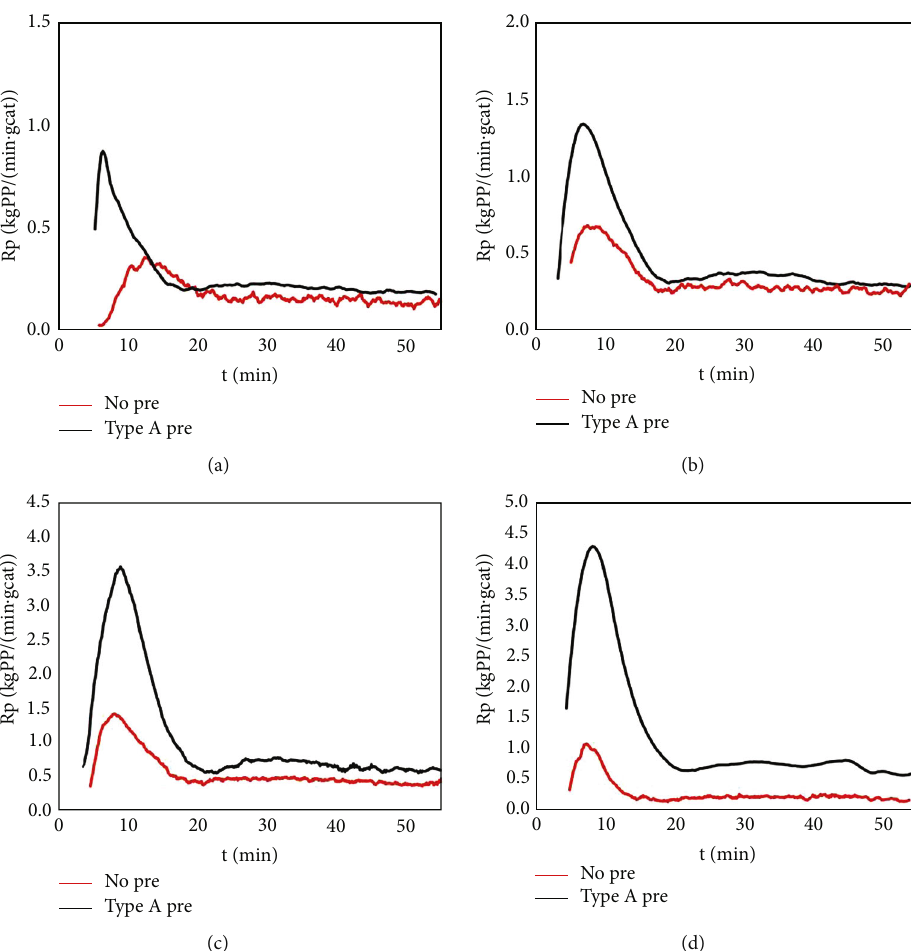
Figure 5: Polymerization kinetic curves at di ff erent temperatures and the same hydrogen concentration. Black lines: type A catalyst injection; red lines: type C catalyst injection; main polymerization temperature: (a) 50 ° C, (b) 60 ° C, (c) 70 ° C, and (d) 80 °